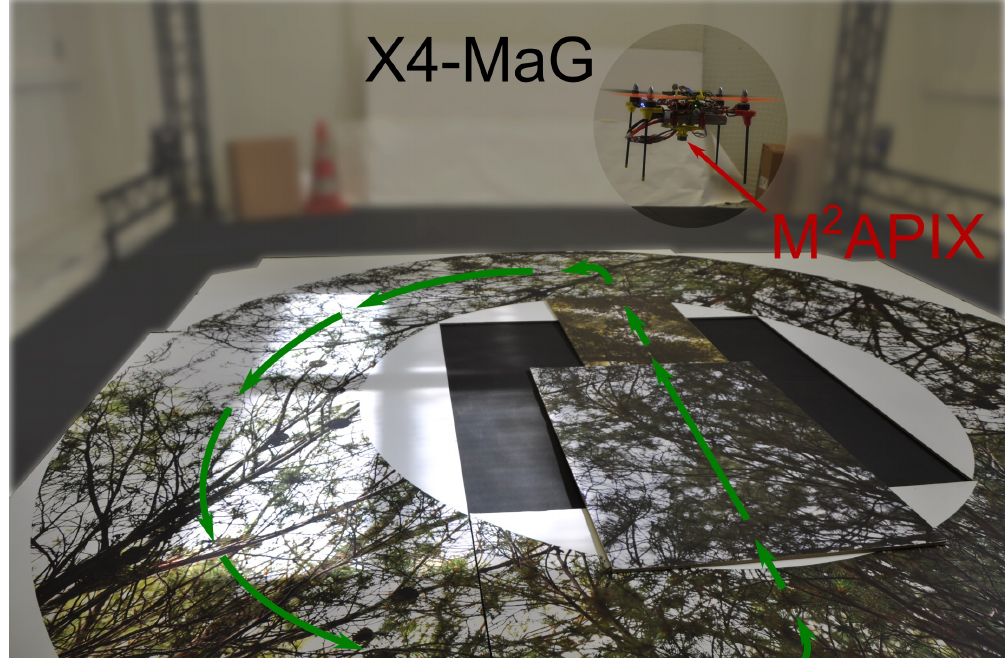
Figure 8. X4-MaG drone hovering at 1.2 m above the natural texture in the flight arena. The half-moon shaped trajectory is represented in green. The M 2 APix sensor is embedded under the quadrotor looking downwards and measuring the OF coming from the ground below. See Video S1 to watch the